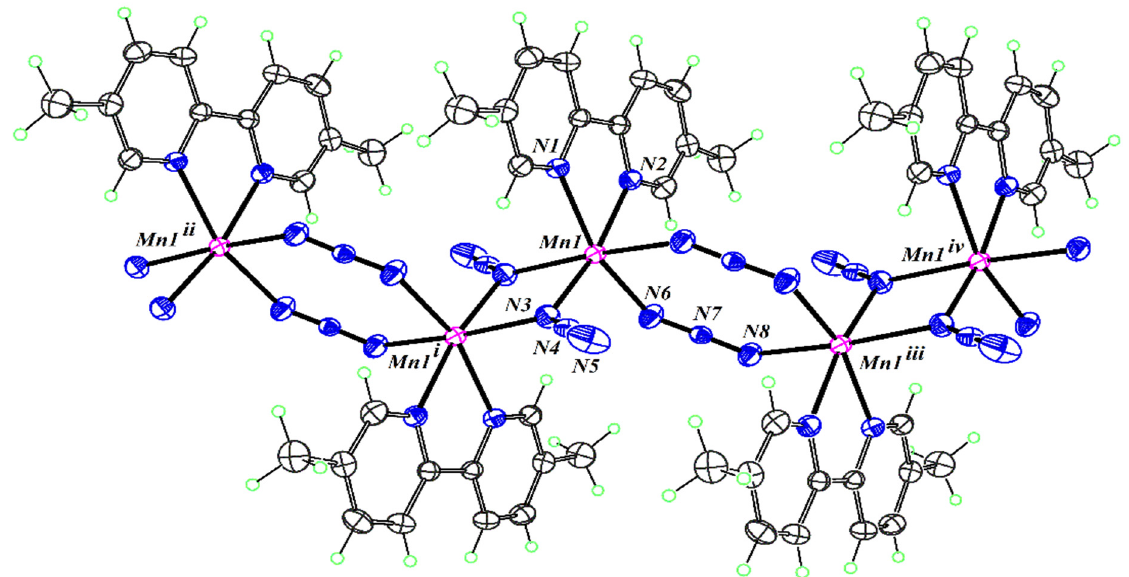
Figure 2. Part of the polymeric structure of c atena -poly-[Mn(N 3 ) 2 (dmbpy)] with displacement ellipsoids for non-H atoms at the 30% probability level. Mn and N atoms belonging to the asymmetric unit are labelled, as well as symmetry-related metallic centers along the chain. Symmetry codes: ( i )1 − x, 1 − y, 1 − z; ( ii ) − 1 + x, y, z; ( iii ) 2 − x, 1 − y, 1 − z; ( iv ) 1 + x, y, z.